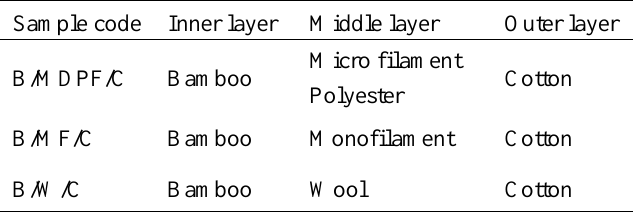
Fig. 1. Wetting time of trilayer knitted